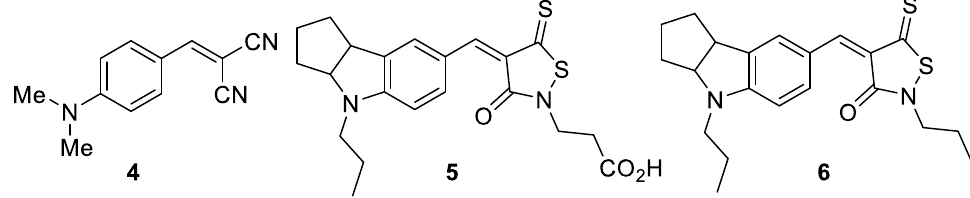
Figure 1. Chromophores with a structure close to that of compound 1 .